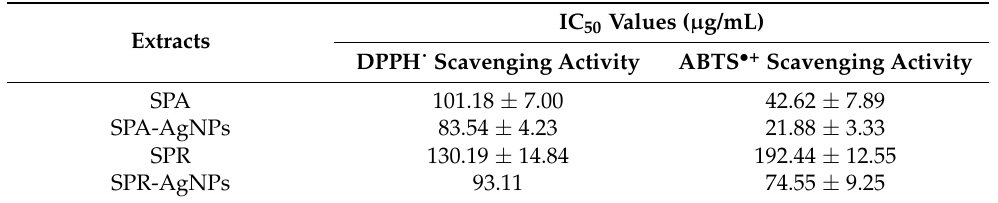
Table 2. Comparison of the antioxidant activity of the synthesized silver nanoparticles against the corresponding S. pratensis